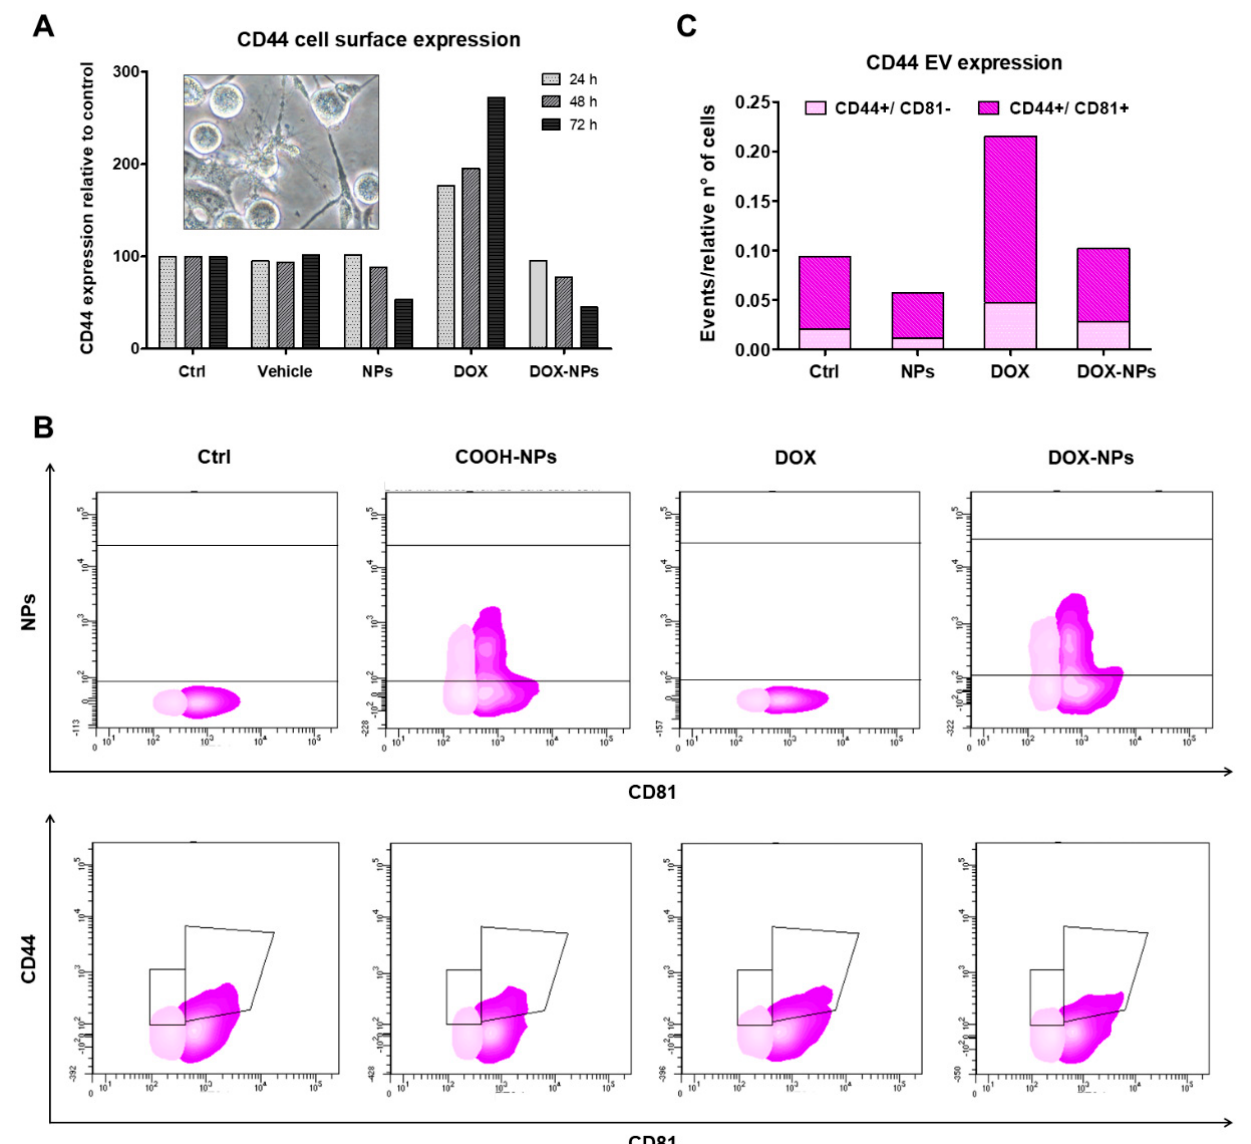
Figure 9. CD44 expression on cell surface and its expression on extracellular vesicles after DOX treatment. ( A ) MCF-7 were incubated with medium (Ctrl neg), DMSO (vehicle), COOH-NPs (diluted 1:50), free DOX (1 µg/mL) and DOX-NPs (1 µg/mL of DOX) for 24, 48 and 72 h at 37 °C, washed and then stained with CD44 RPE. Mean fluorescence intensity (MFI) data were acquired by flow cytometry and normalized to control ( n = 2). ( B ) Flow cytometry contouring plots (above: NPs channel vs. CD81 FITC; below: fluorescence of particles CD44 RPE vs. CD81 FITC) of supernatants, presenting in pink CD81 − particles or violet CD81+ particles. ( C ) The histogram shows the quantification of extracellular vesicles (EVs), counted using Dako CytoCountTM beads, in Ctrl, COOH-NP, DOX and DOX-NP media containing CD44+/CD81 − and CD44+/CD81+ particles ( n = 2). The color scheme is the same as contouring plots. At least 10,000 events were analyzed by flow cytometry for cells and at least 30,000 events for EVs for each experimental condition.